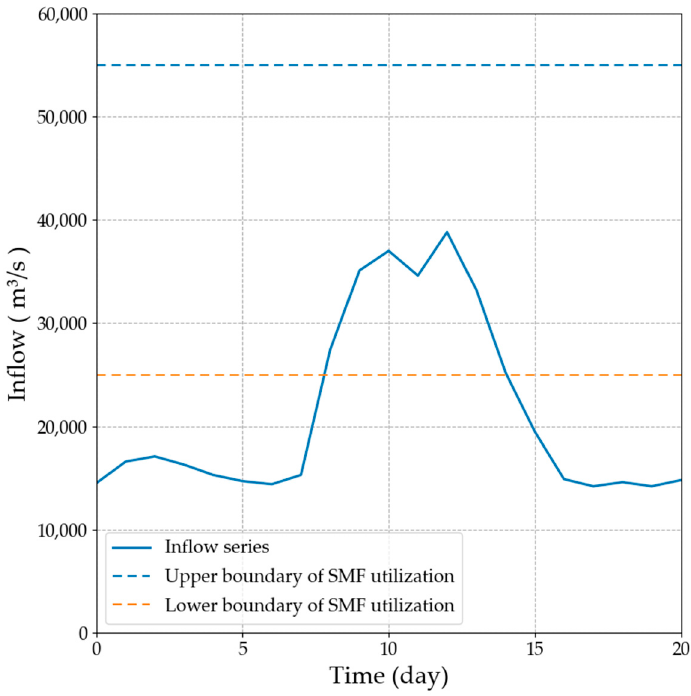
Figure 4. Inflow of the cascade reservoir system during the operational period.